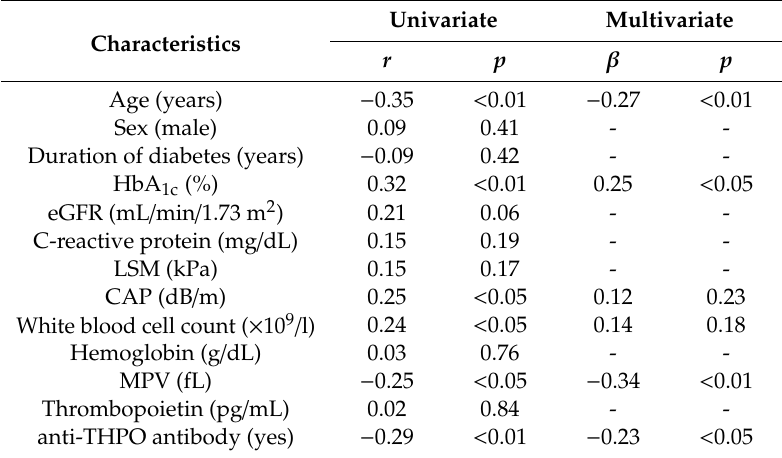
Figure 2. Comparison of the platelet count according to the presence / absence of the anti-THPO antibody. The data of the two groups were compared by the Student’s t -test (* p -value < 0.05). Lines indicate the mean and standard deviation for each group. THPO: Thrombopoietin. Table 2. Univariate correlation (left columns) and multivariate linear regression (right columns) Table 1. Clinical and laboratory characteristics of the patients ( n = 82). determining the factors that a ff ect platelet count ( n =